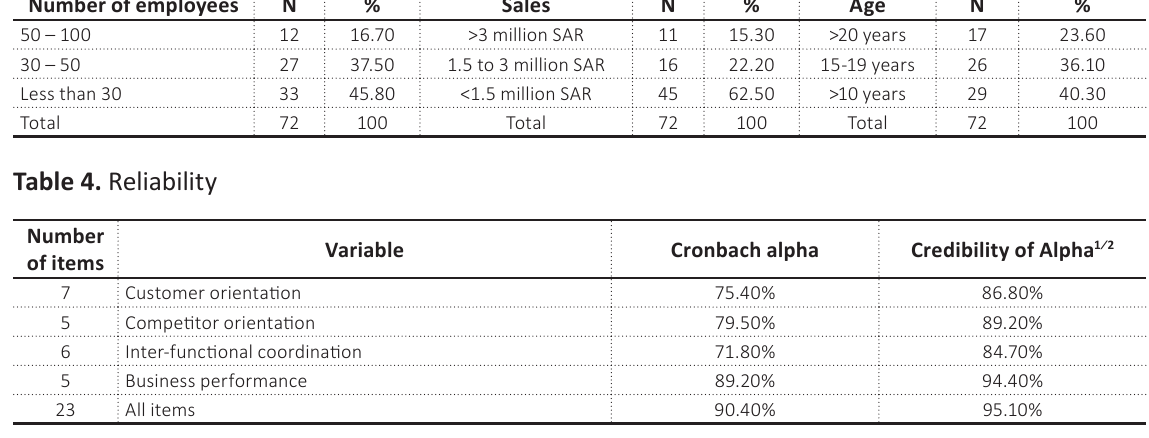
Table 3. Characteristics of the type of companies investigated by the number of employees Number of